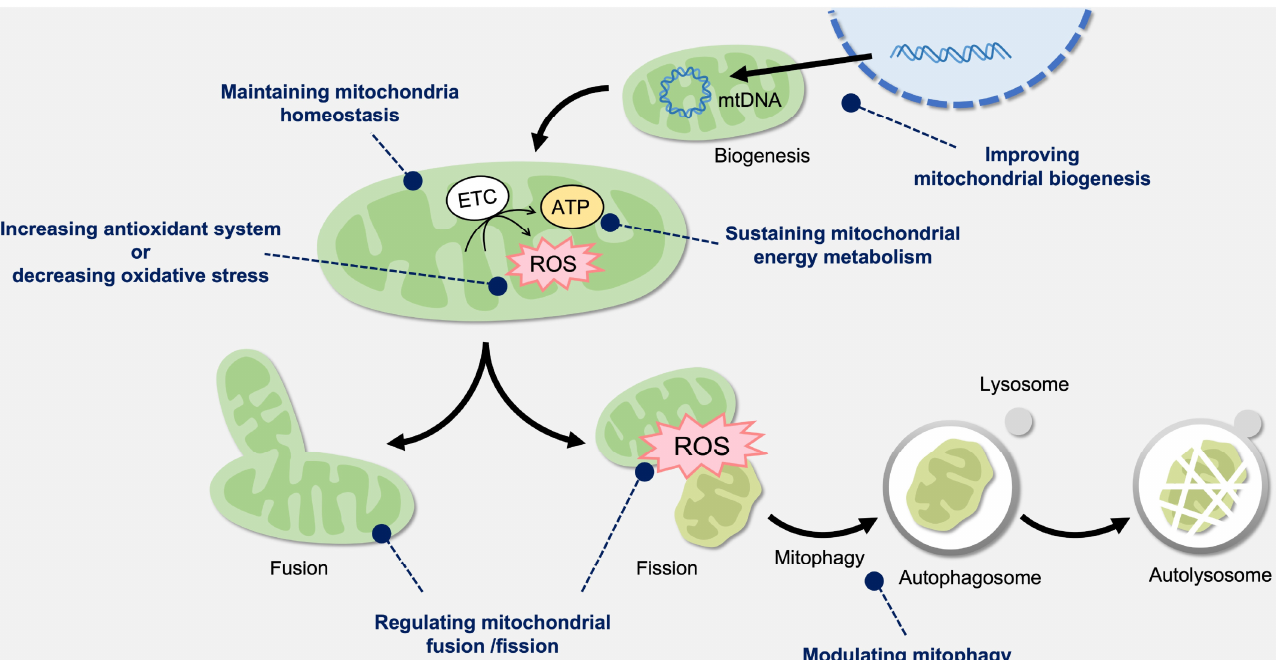
Figure 2. Mitochondria-targeted therapeutics for oxidative damage. Mitochondria produce energy via the oxidative phosphorylation process in the electron transport chain (ETC) present in the mito- chondrial membrane. Mitochondrial membrane potential (MMP) plays a key role in mitochondrial homeostasis. To maintain mitochondrial function, fusion reduces stress and enhances integrity by sharing the contents as a form of complementation. Fission segregates the damaged region of mitochondria. Mitochondrial biogenesis is the process that regulates the number of healthy mito- chondria, resulting in increased ATP production. Mitophagy is the selective process for removing the dysfunctional mitochondria. The complicated processes can control mitochondrial quality and cell metabolism, which may also provide possible therapeutic targets for oxidative